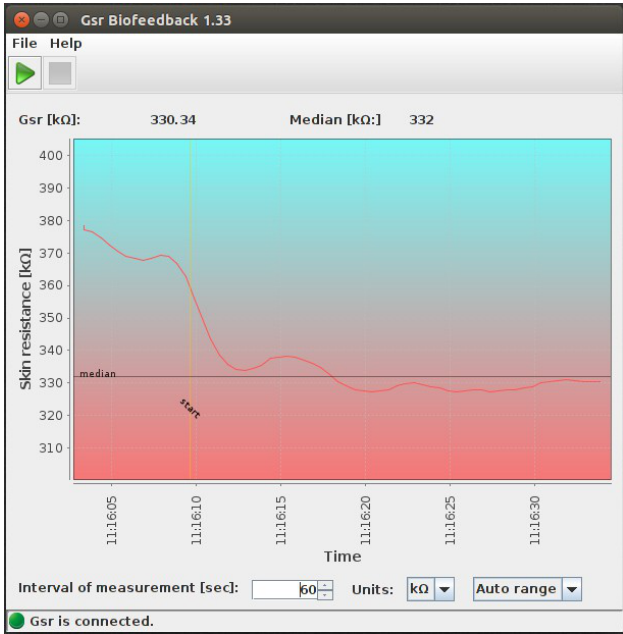
Figure 5. GSR Studio software plots data into graph in real time (photo from supplier).